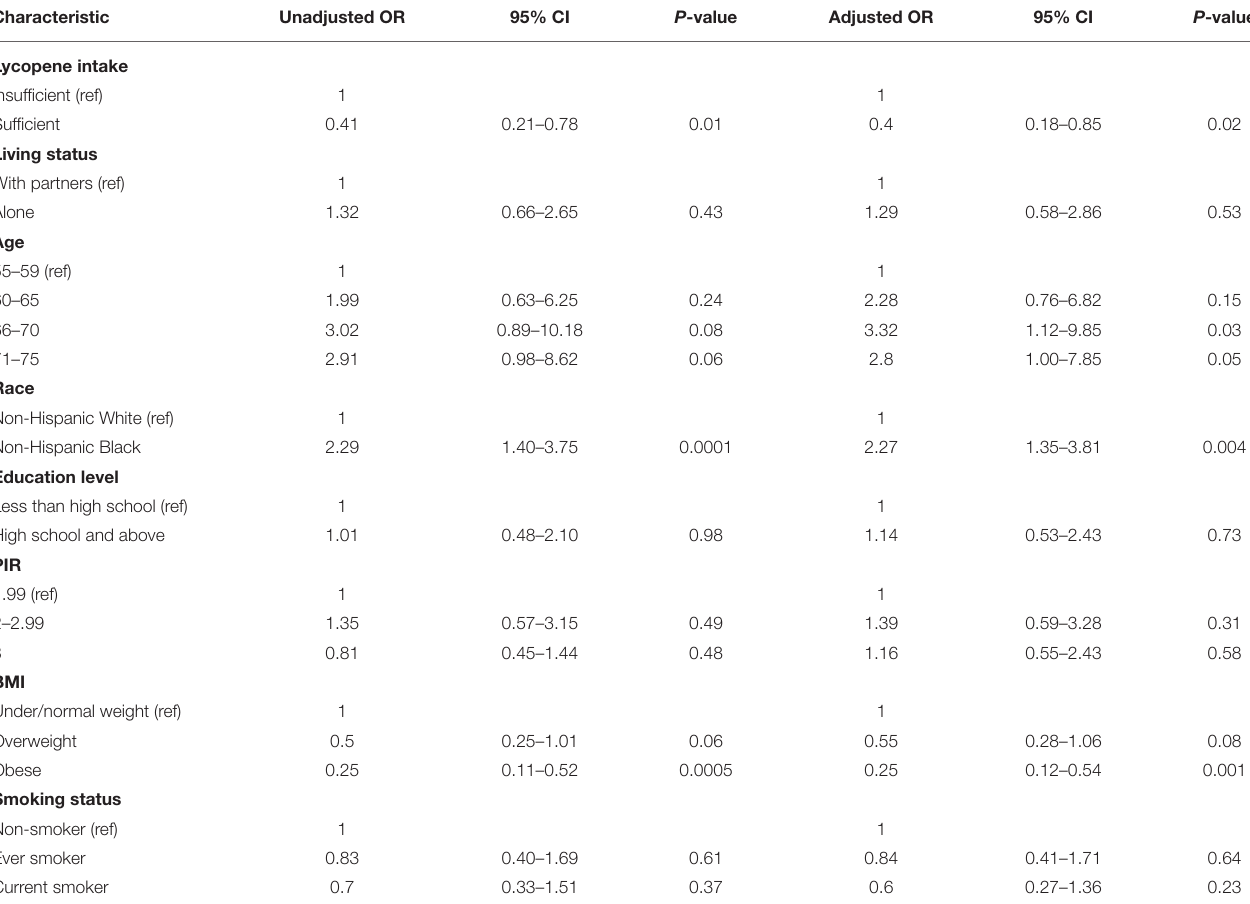
TABLE 2 | Factors associated with a high risk of PCa (Total PSA 4.0ng/ml and ratio of free PSA 25%).